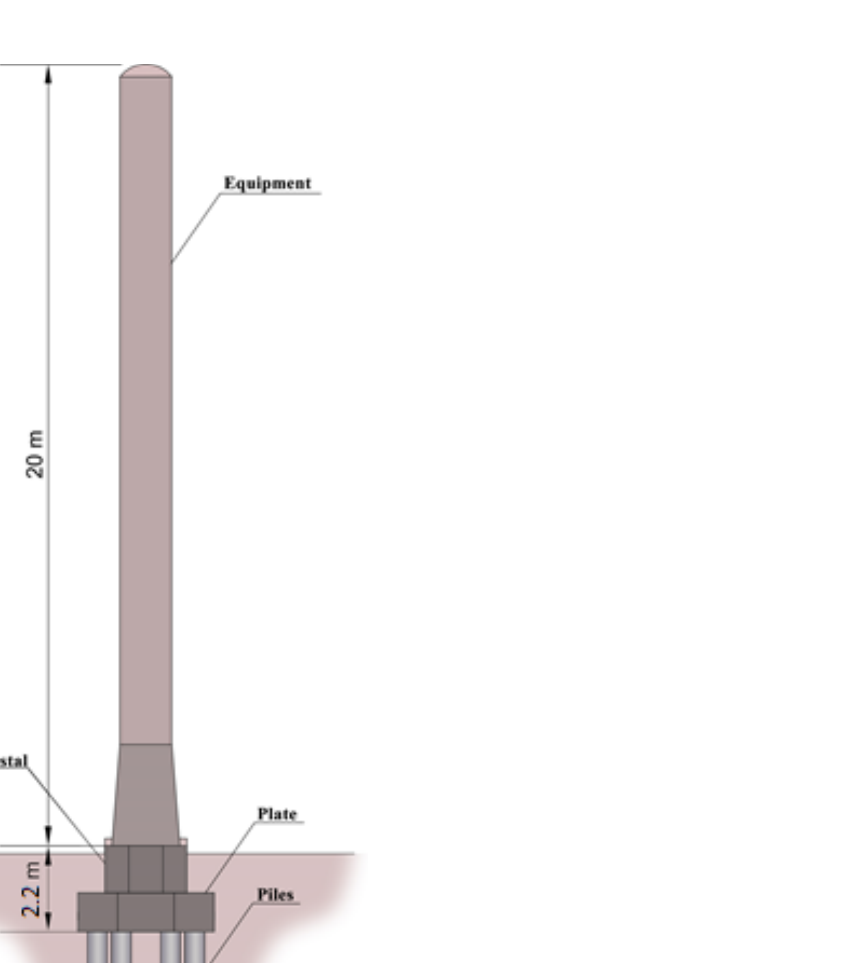
Figure 11. Scheme of the cooling tower.